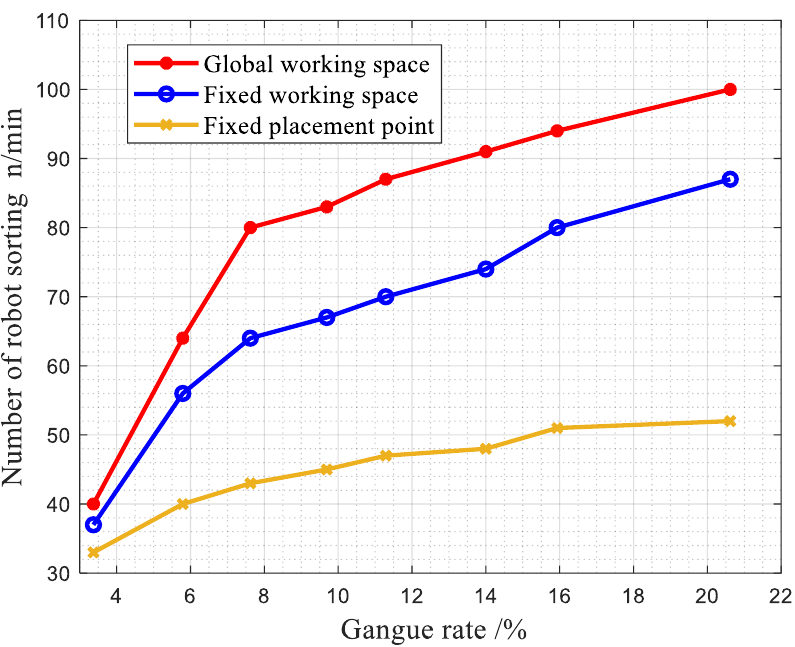
Figure 20. Sorting times of robots with the same belt speed and different gangue contents.